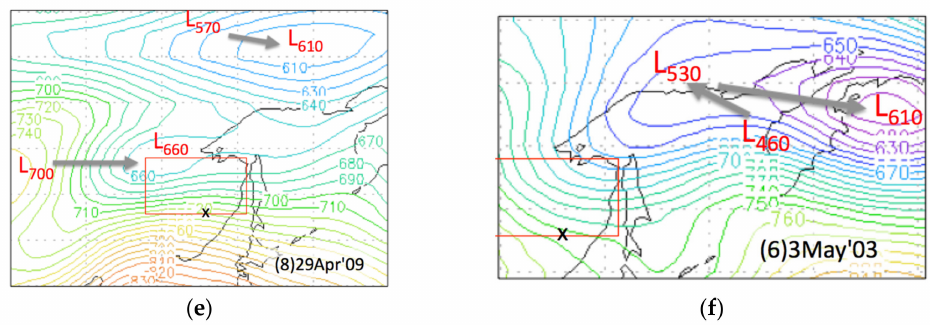
Figure 7. Low-pressure systems associated with March-Fire and April-Fire. ( a ) (11)9Mar (cid:48) 08; ( b ) (4)10Apr (cid:48) 03; ( c ) (3)20Apr (cid:48) 08; ( d ) (5)24Apr (cid:48) 18; ( e ) (8)29Apr (cid:48) 09; and ( f ) (6)3May (cid:48) 03.